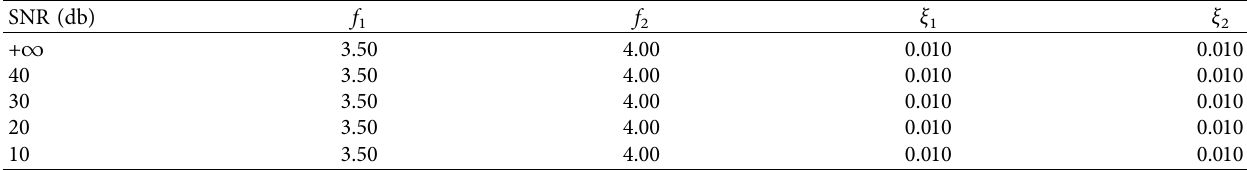
Table 2: Identification results for various signal-to-noise ratios (SNRs) with closely spaced